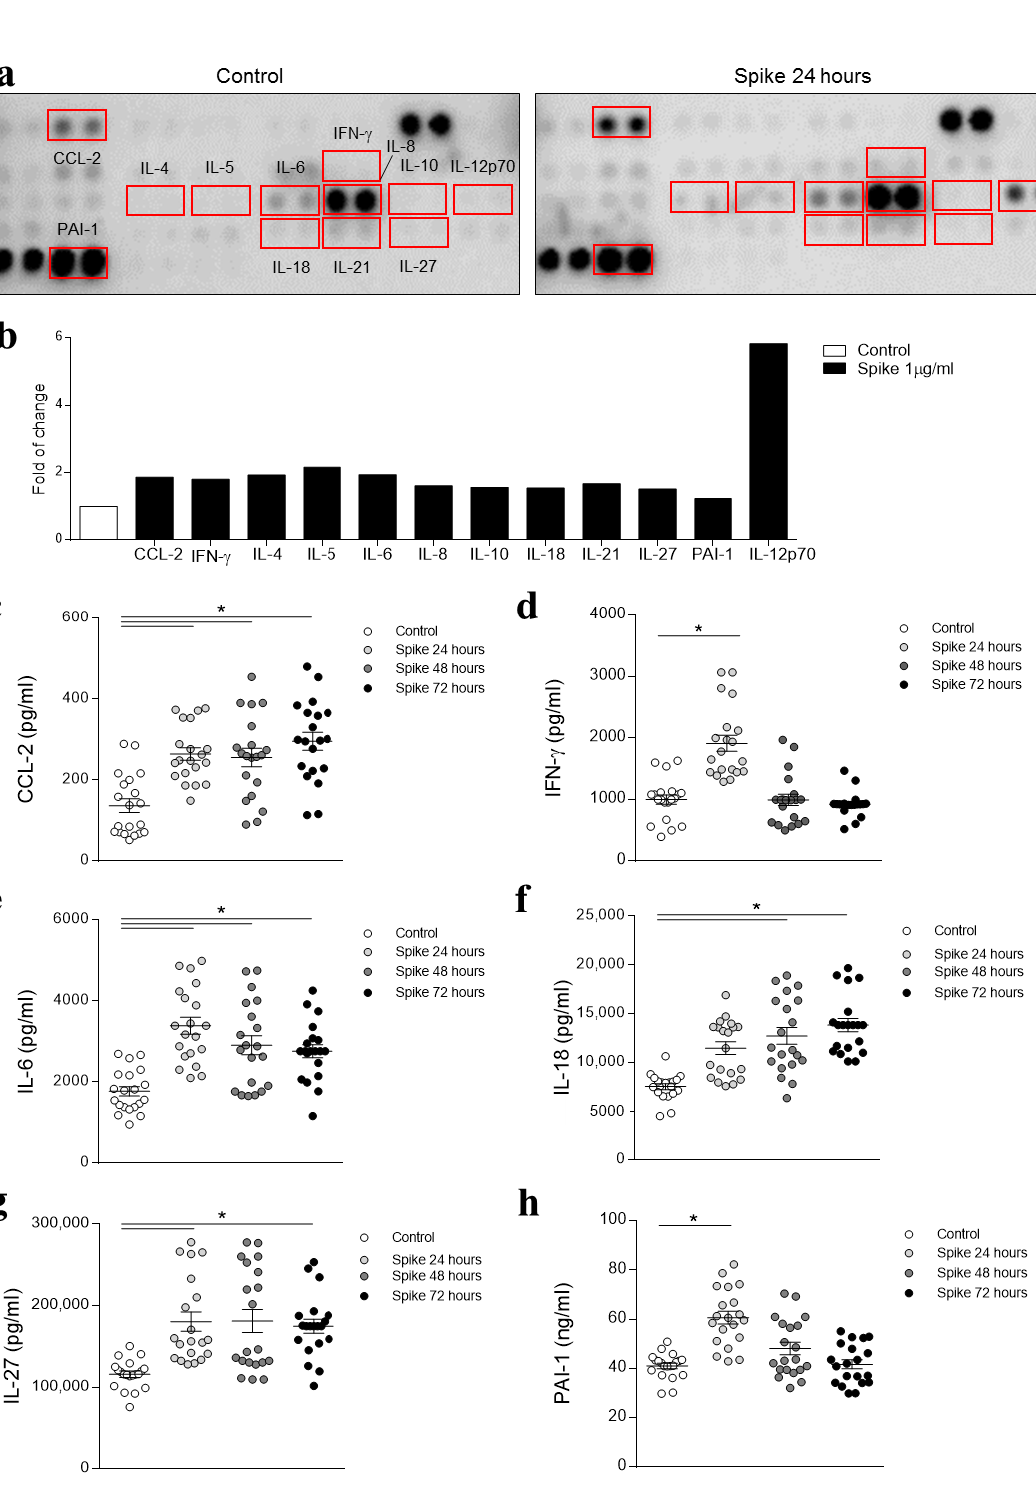
Figure 2. Effects of recombinant Spike protein on HAECs. Representative images of human cytokine array blots probed with the supernatant samples of controls and Spike-treated cells for 24 h ( n = 12 supernatants per condition of 3 independent experiments). Each blot represents the immunoreactive staining with each cytokine. The lack of dots represented the negative and blank control. The blots marked inside the box are those selected ( a ). The fold-change of cytokines was determined by comparing the pixel intensity of the respective blots to that of the positive control on the same array ( b ). Quantification of CCL-2, IFN- γ , IL-6, IL-18, IL-27, and PAI-1 secretion in HAECs treated with recombinant Spike for 24, 48, and 72 h (Control, n = 20; Spike 24 h, n = 20; Spike 48 h, n = 20; Spike 72 h, n = 20) ( c – h ). Results were analyzed using one-way-ANOVA followed by Dunnet’s post-hoc multiple comparisons tests. * vs.